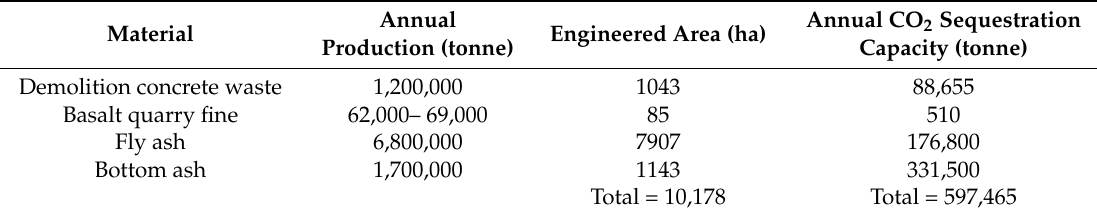
Table 2. Annual production for the three types of industrial waste in Malaysia suitable for inorganic CO 2 sequestration, area of land that could be engineered, and the country’s annual CO 2 sequestration